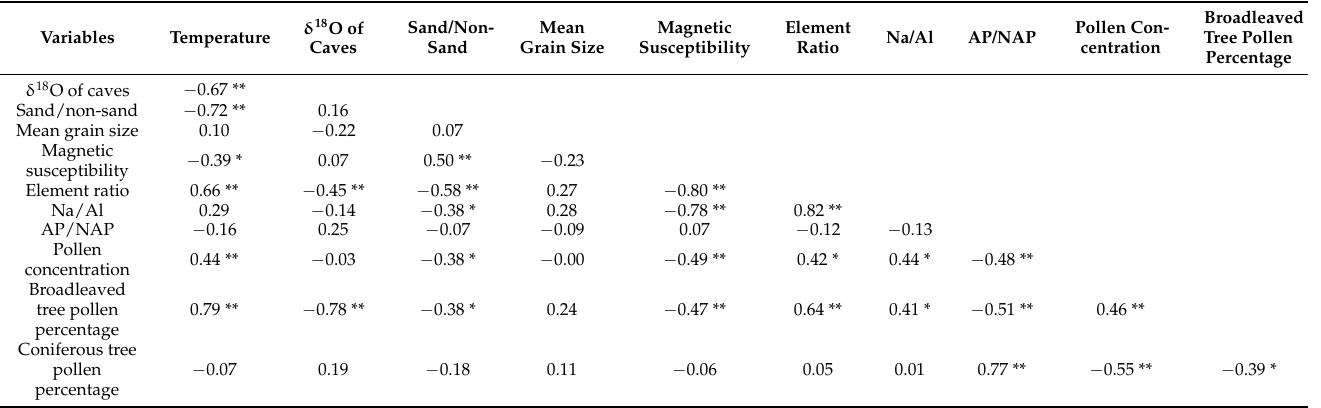
Table 1. Correlation coefficients ( R ) among selected climate/environmental variables. These original data were obtained from the reference list in Table 2.